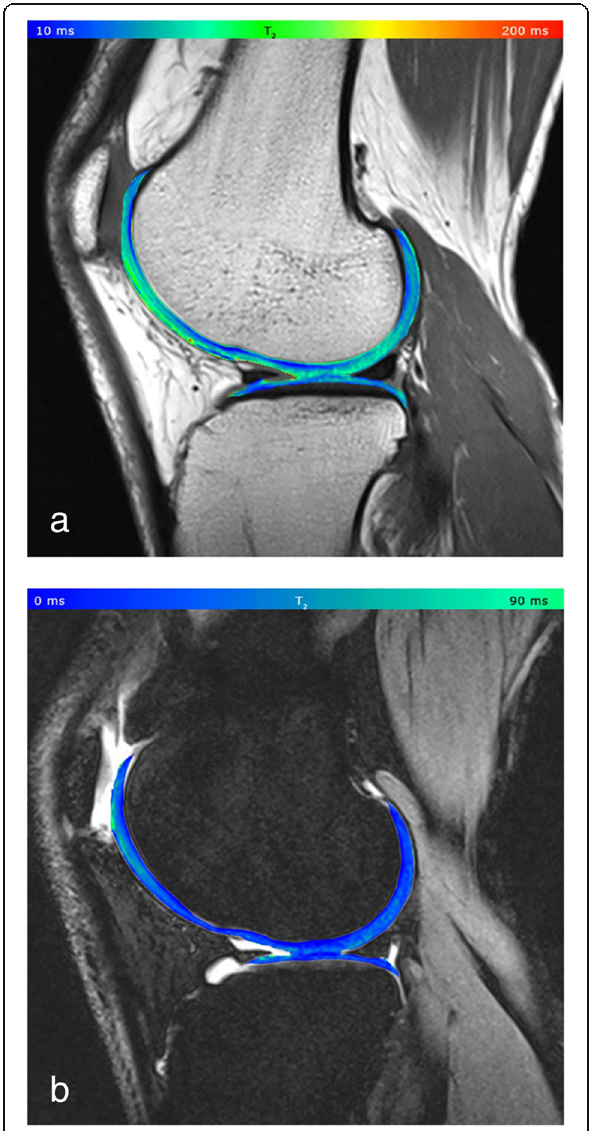
Fig. 3 a T2 map acquired with Carr-Purcell-Meiboom-Gill (CPMG) multi-echo spin-echo (MESE) sequence, pseudo-colour-coded and overlaid on a morphological image of a 41-year-old patient with Pridie drilling on the medial femoral condyle (echo time 11.9 ms). The ratio between the native and lesion cartilage T2s was 0.81. b T2 map acquired with a three-dimensional triple-echo steady state (3D TESS) sequence, pseudo-colour-coded and overlaid on the second acquired image (F 0 , the lowest order steady state free precession — free induction decay mode acquired in the repetition time). The ratio between the native and lesion cartilage T2s was 0.83. Focal increase in T2 values is observable with both techniques. Bone oedema is also present (arrow). The dynamic range of the CMPG MESE T2 map is higher compared to that of the 3D-TESS T2 map: the lesion appears to be more diffuse, although the ratios between native and lesion cartilage T2s are comparable. Reprinted with permission from: Juras et al., Eur Radiol 2016 (reference